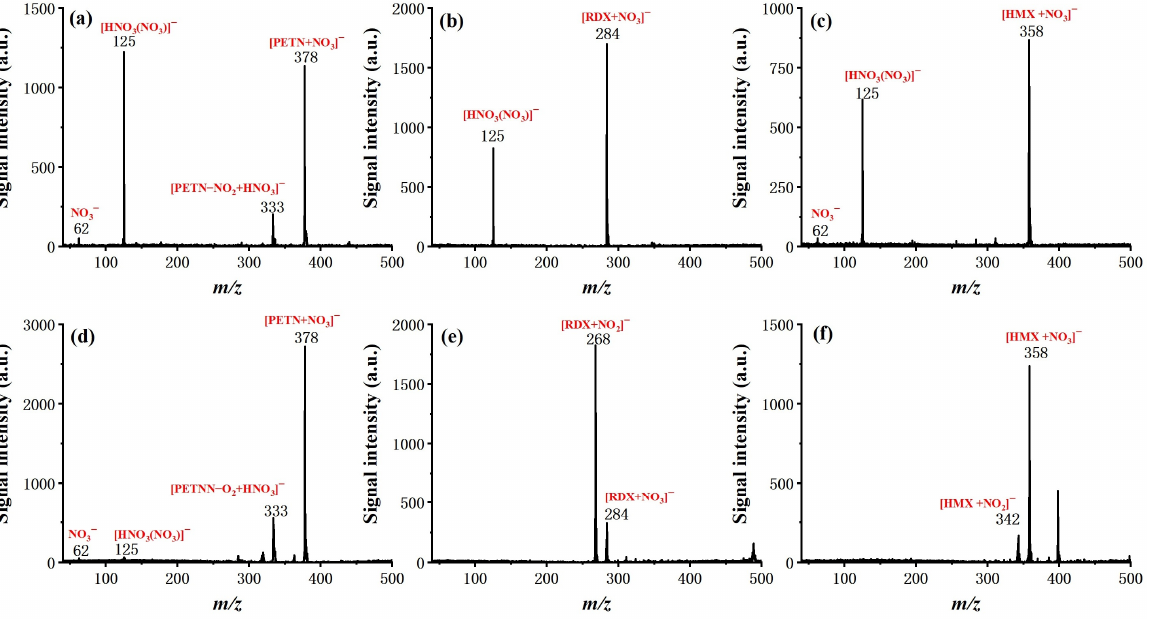
Figure 6. Mass spectra of PETN, RDX, and HMX with 100 ng, respectively, with discharge gas flow of 800 mL/min. ( a ) PETN with forward flow; ( b ) RDX with forward flow; ( c ) HMX with forward flow; ( d ) PETN with counter flow; ( e ) RDX with counter flow; ( f ) HMX with counter